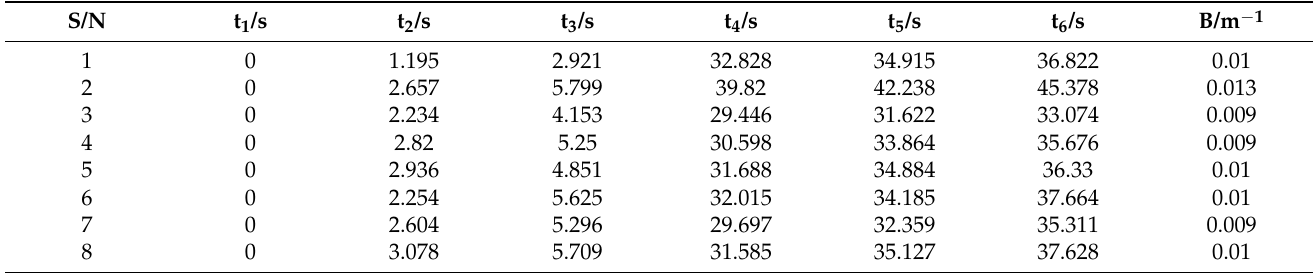
Table 1. Average values of B and pulse-time calibration using a conventional model.